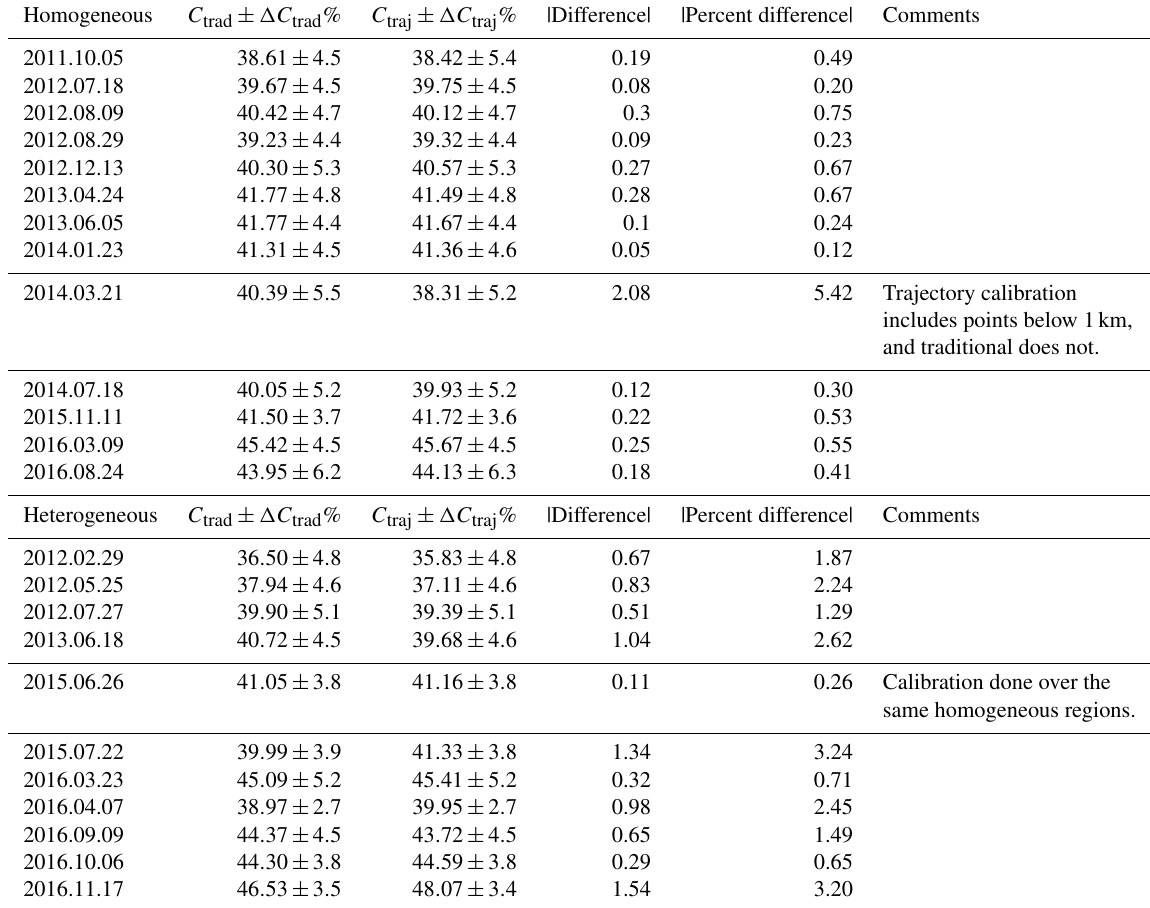
Table 1. A comparison of the calibration constants of all nights used in this study. The table is split into two sections – homogeneous and heterogeneous nights. Column 1 is the date on which the radiosonde was launched (yyyy-mm-dd). Column 2 or C trad is the traditional cali- bration constant with its total percent uncertainty. Column 3 or C traj is the trajectory method calibration constant with its percent uncertainty. Column 4 is the absolute value of the difference between the two constants. Column 5 is the absolute value of the percent difference of the two constants with respect to the traditional calibration constant. Column 6 is for comments regarding the